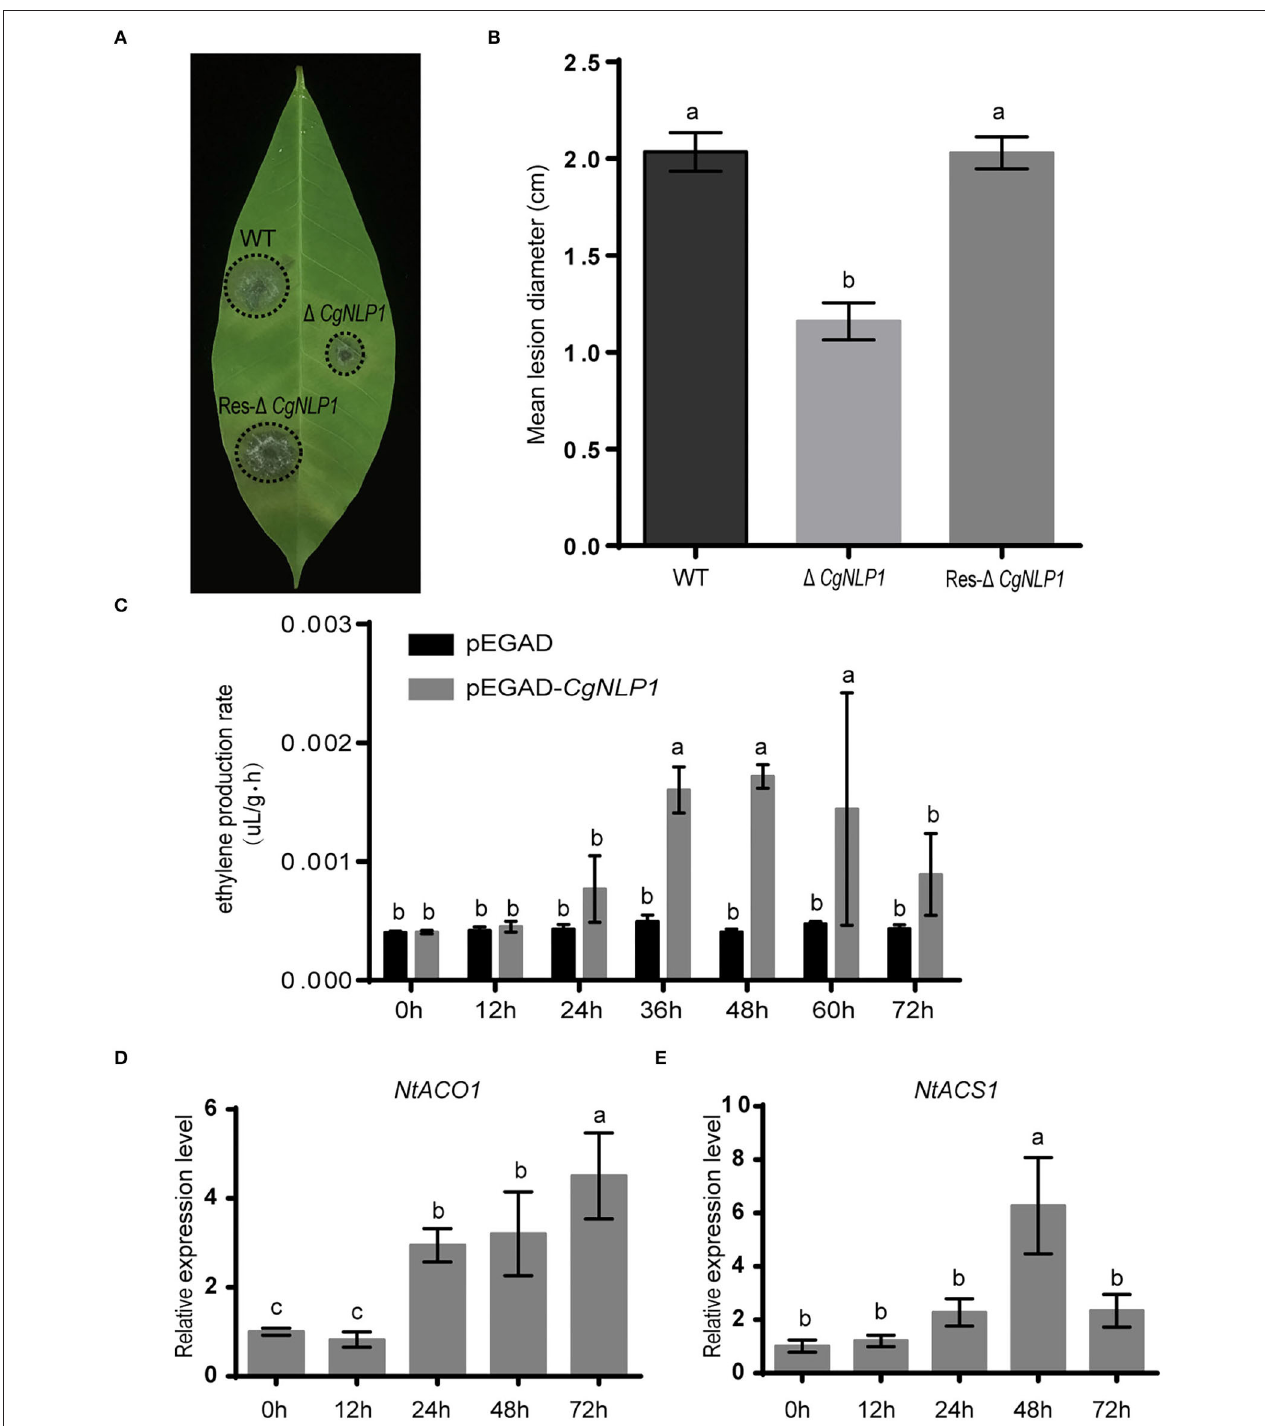
FIGURE 2 | CgNLP1 contributed to the virulence of Colletotrichum gloeosporioides in the rubber tree and induced ethylene production in plants. (A) Disease symptoms on rubber tree leaves at 4 days of post-inoculated with conidia of 1 CgNLP1 , Res- 1 CgNLP1, and wild type (WT). (B) Statistical analysis of lesion diameter after inoculation with WT, 1 CgNLP1, and Res- 1 CgNLP1. (C) The ethylene content in tobacco leaves expressing CgNLP1 . pEGAD represents the tobacco leaves expressing empty vector pEGAD, and pEGAD-CgNLP1 represents the tobacco leaves expressing constructive vector pEGAD-CgNLP1. (D) The expression pattern of NtACO1 (LOC107781126) in tobacco leaves expressing CgNLP1. (E) The expression pattern of NtACS1 (LOC107831434) in tobacco leaves expressing CgNLP1 at different time points. Data are shown as the means ± standard deviation (SD) from three independent experiments, and columns with different letters indicate a significant difference ( P <